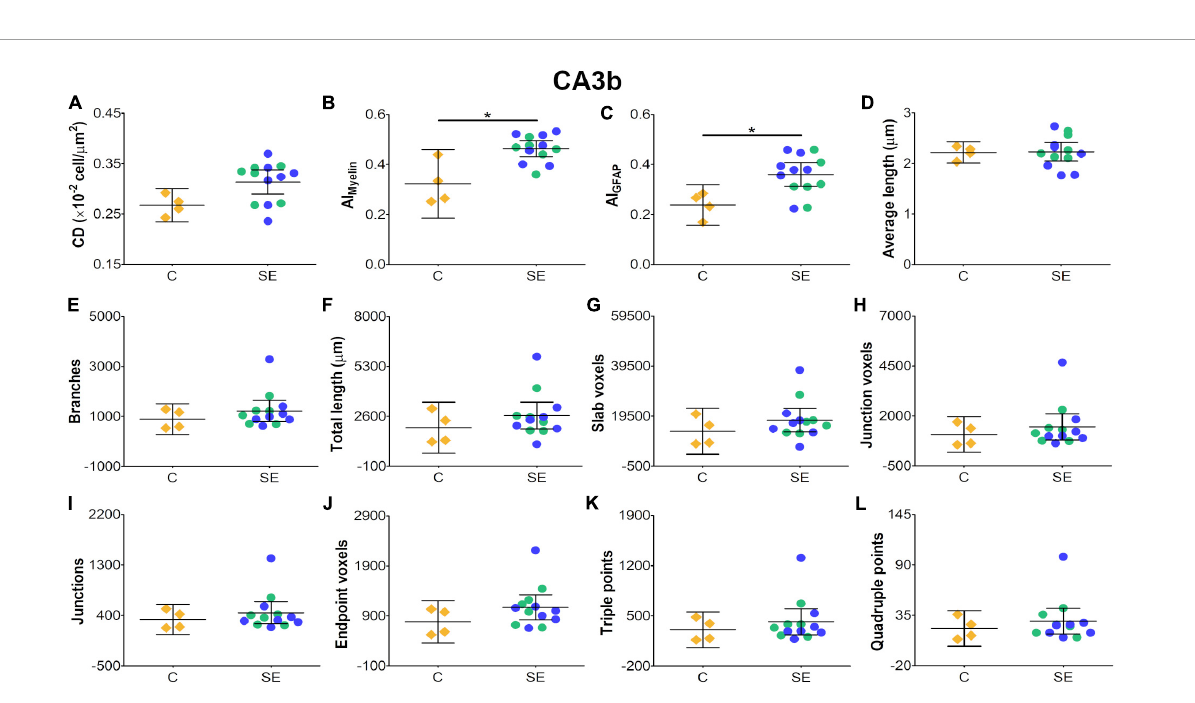
FIGURE7 Histological-derived parameters from automated cell counting analyses (A) , structure-tensor (ST)-based analyses of myelin (B) , and ST (C) and skeleton-based analysis (D–L) from GFAP-stained sections in the subfield CA3b. Notations as in Figure 4 . SE animals revealed increases in AI Myelin (B) and AI GFAP (C) parameters as compared to controls (BH-FDR-corrected q -value * < 0.05; two-side permutation t -test). AI, anisotropy index; C, control; CD, cell density; SE, status